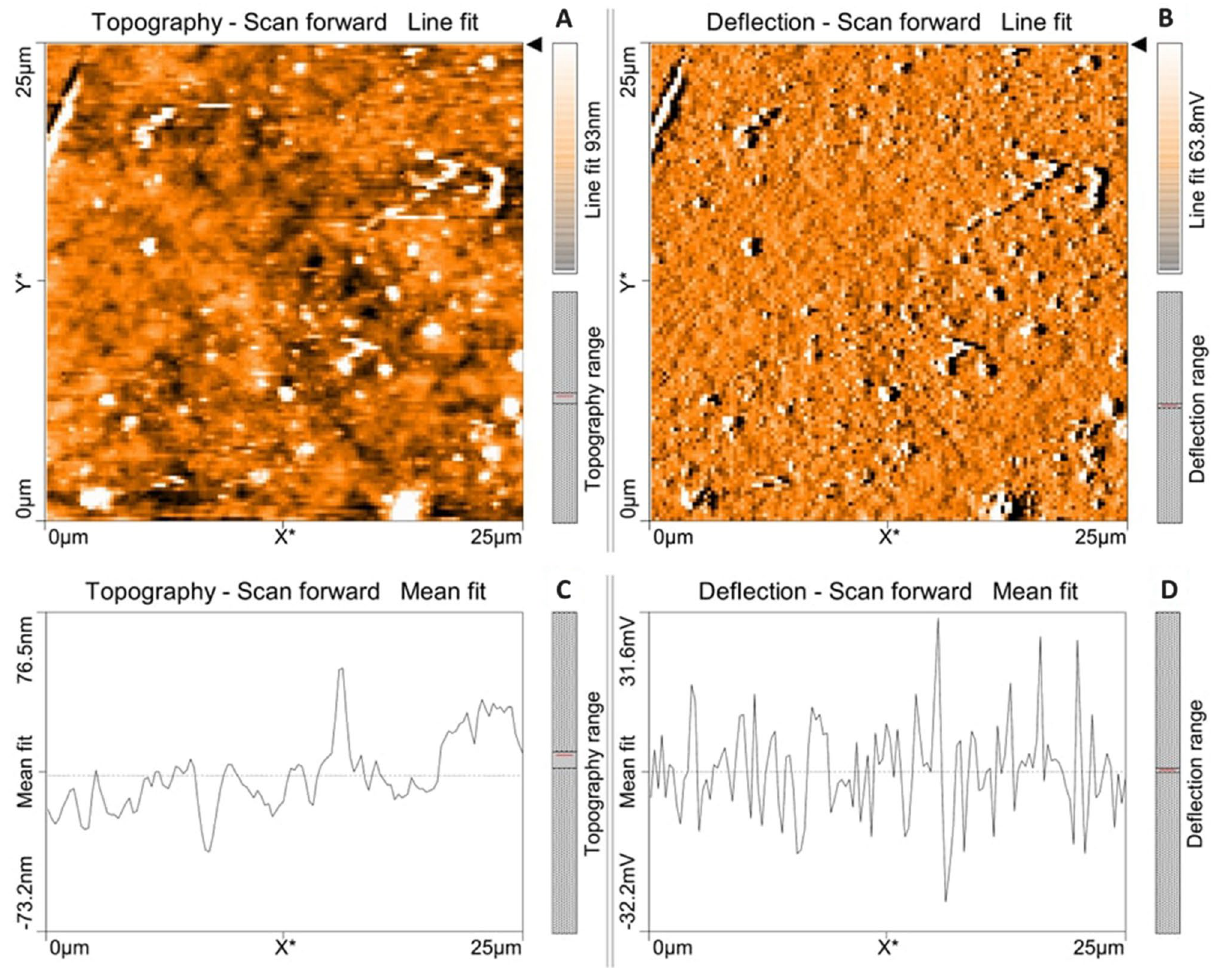
Figure 22. Atomic force microscopic results obtained for control (untreated) LDPE sheet of 25 µm 2 area: ( A ) Topography of the surface (Line fit); ( B ) Voltage deflection (Line fit); ( C ) Topography with mean fit; and ( D ) Voltage deflection with mean